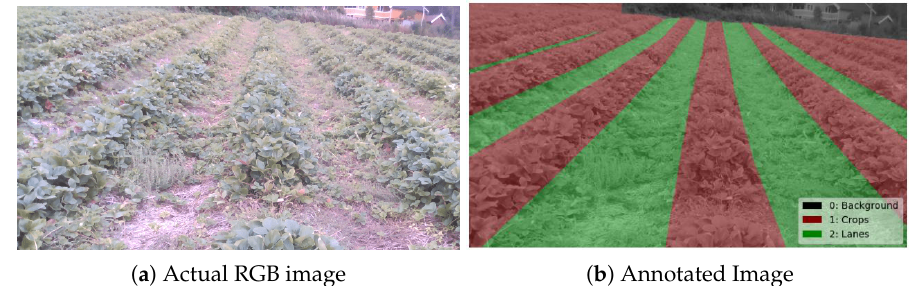
Figure 3. Overlay of the annotated mask on the RGB image for